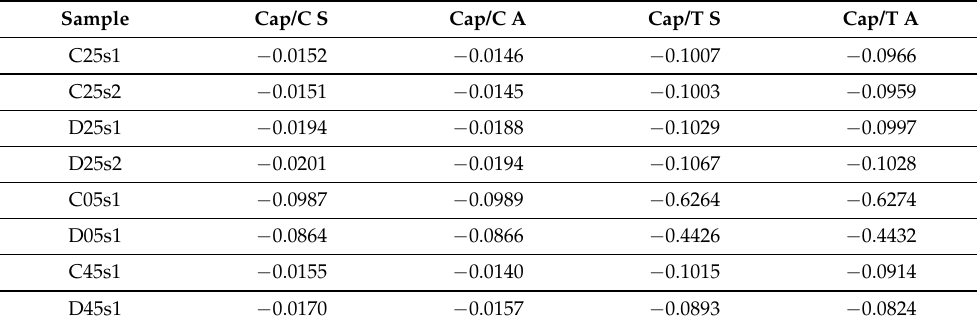
Figure 17. Ratio of Capacity ( a ) and energy ( b ) of all the consecutive capacity tests. Solid line is used for better visibility, but there are no results except for the cycles identified by plot markers. Tables 4 and 5 show the resulting regression coefficients of measured capacity and energy, respectively, for capacity test cycles. Table 4. Linear regression coefficients of capacity depending on cycle no. (denoted as /C) or time (denoted as /T) in days considering the second capacity test (denoted as S) or all the capacity tests (denoted as A) for individual samples.